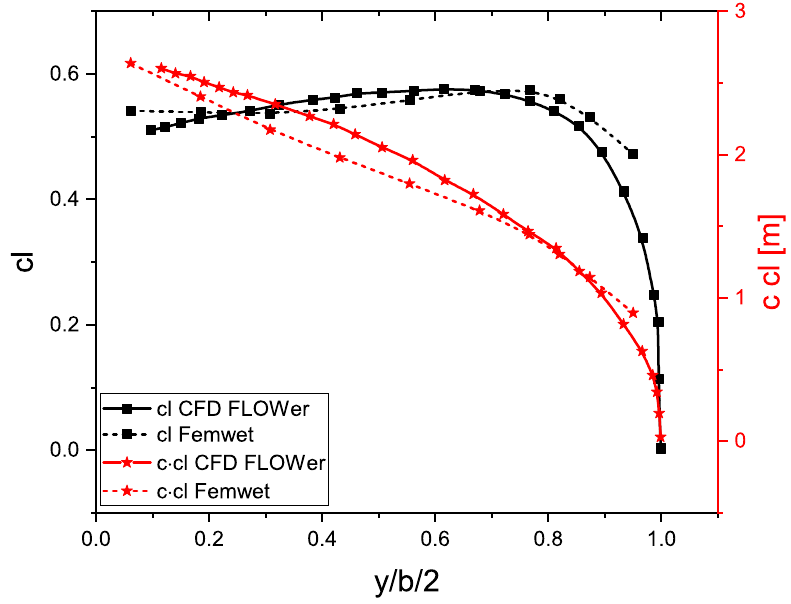
Figure 8. TuLam wing lift distribution from [43] and using